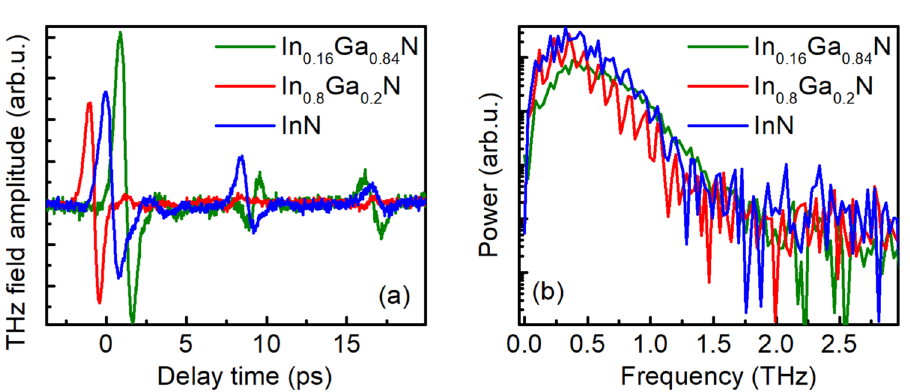
Figure 1. Temporal shape of THz pulse ( a ) and its Fourier spectrum ( b ) emitted from In 0.16 Ga 0.84 N (green lines),